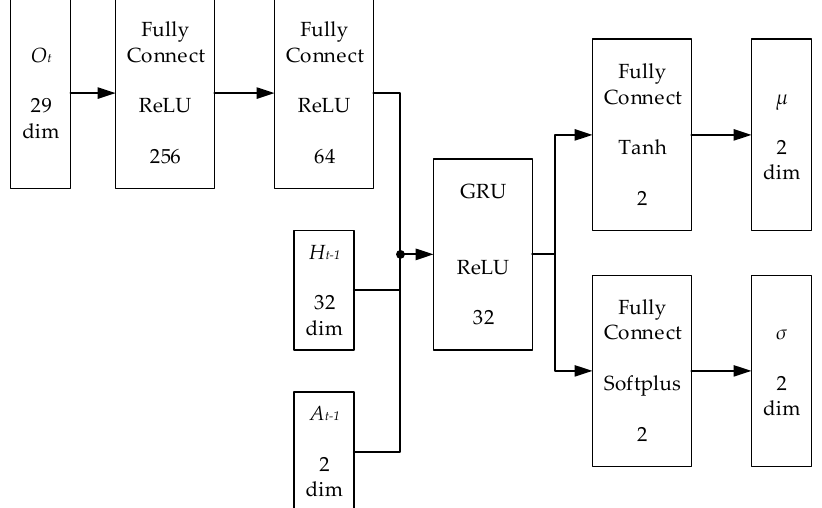
Figure 4. The structure of actor network in MK-A3C. O t denotes the current observation. H t − 1 is the last hidden states of GRU layer. A t − 1 denotes last action. µ denotes expectation of the output action probability distribution, and σ denotes variance. The structure of critic network is similar to that of actor network, but replaces two streams of the output layer of the actor network with one stream and no activation function.